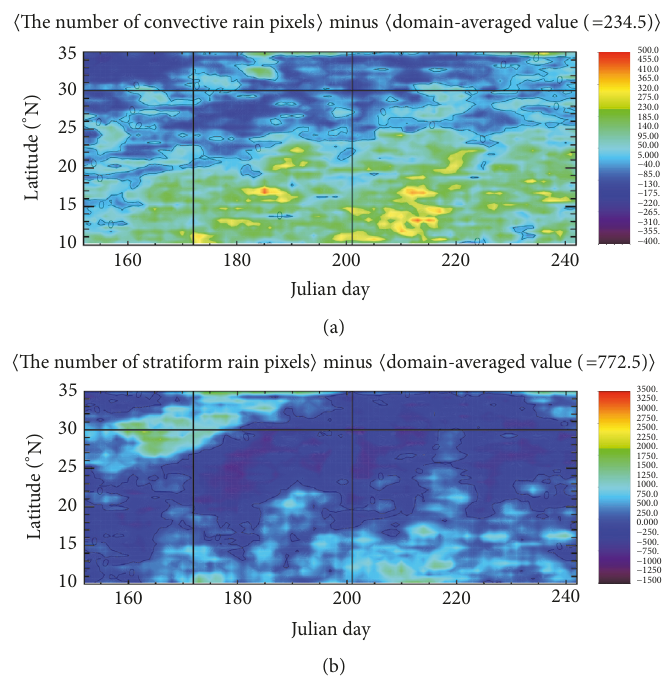
Figure 7: Climatological anomaly propagation of the number of rain pixels for (a) convective and (b) stratiform rain types in the 2- dimensional space with time (Julian day) and latitude. The two vertical lines represent the climatological onset and retreat dates of